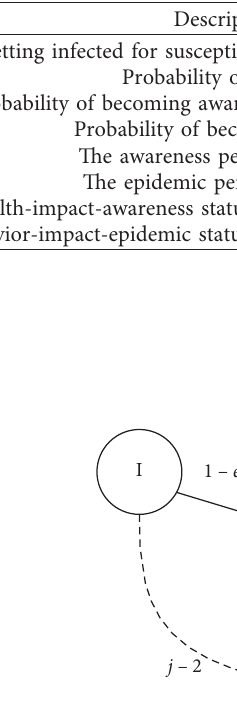
Figure 3: Illustration of the behavior-impact-epidemic status of infected neighbors in layer 2. j is the total number of an individual’s infected neighbors, and 1 − e (− k j / 􏽐 k ) is a positive correlation function of each neighbor’s